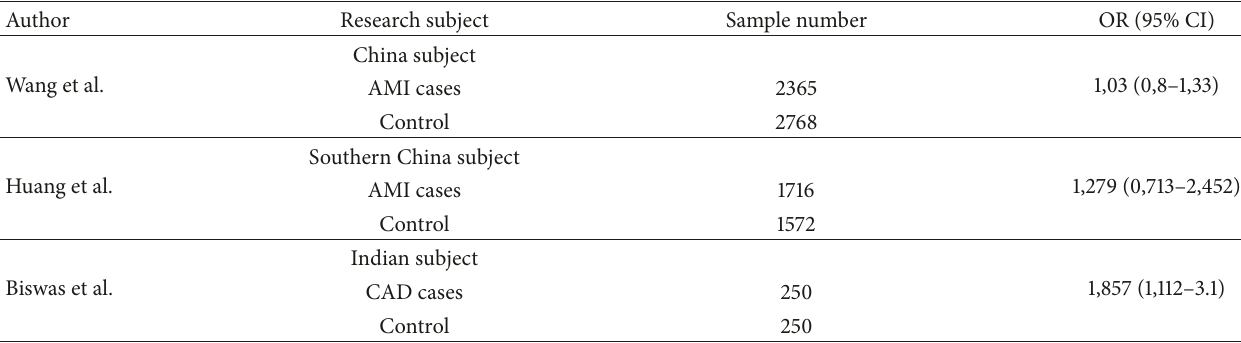
Table 6: Research summary of ABO gene polymorphisms on other